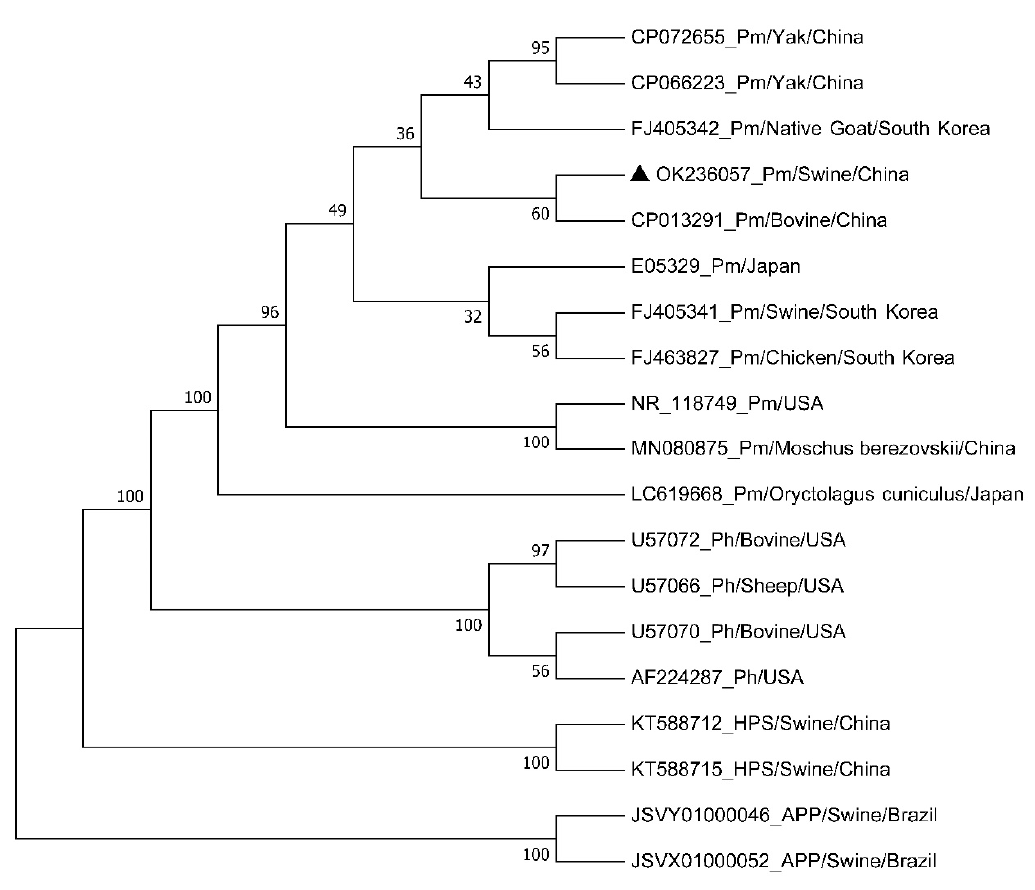
Figure 5. Phylogenetic trees of the bacterial isolate and the reference strains based on 16S rDNA sequences. The information of the reference strains is shown in Table 3. Pm: P. multocida ; Ph: P. hemolyticus ; HPS: H. parasuis ; APP: A. pleuropneumoniae; ▲ The bacterial isolate HBShz_2021.